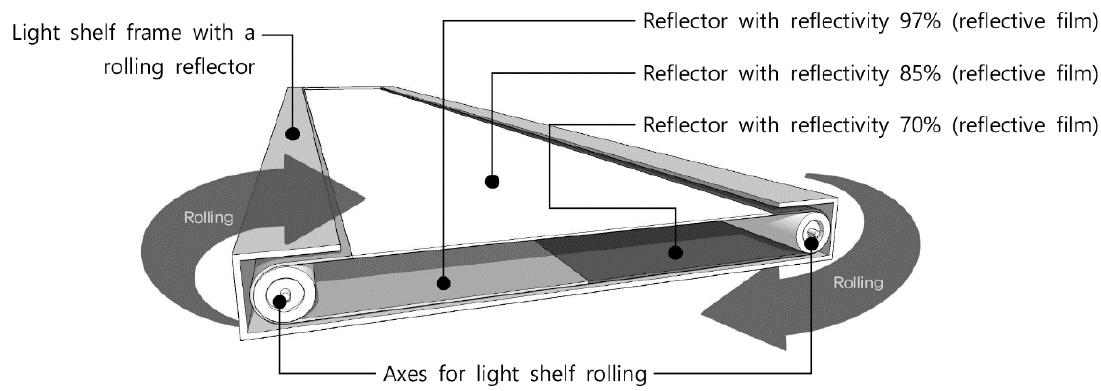
Figure 3. Internal structure of a light shelf with a rolling reflector.